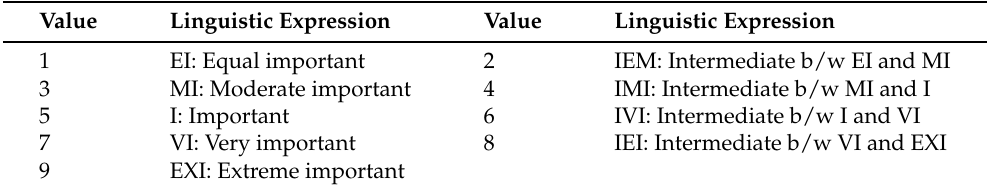
Table 1. Linguistic expression for reference comparison.